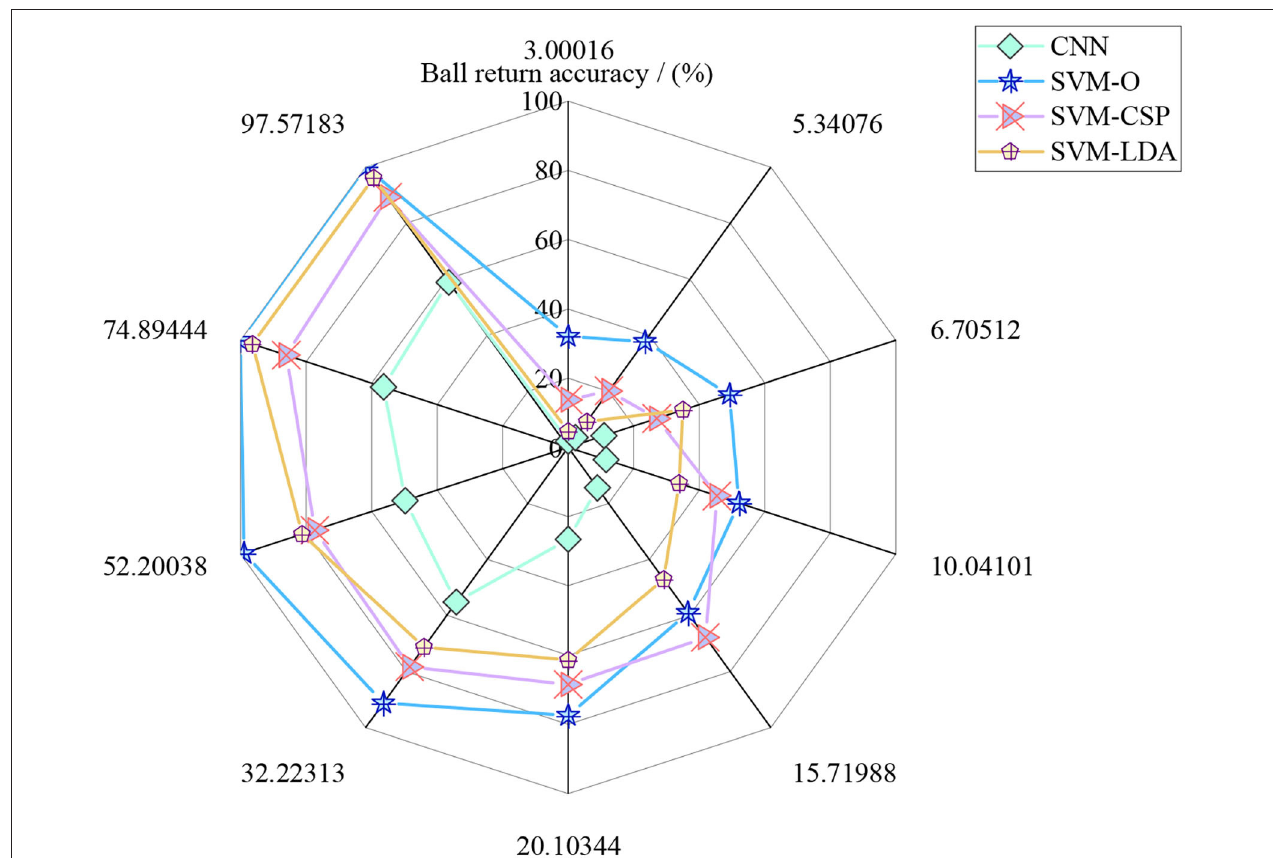
FIGURE 12 | Simulation effect of the return accuracy of the tennis sports